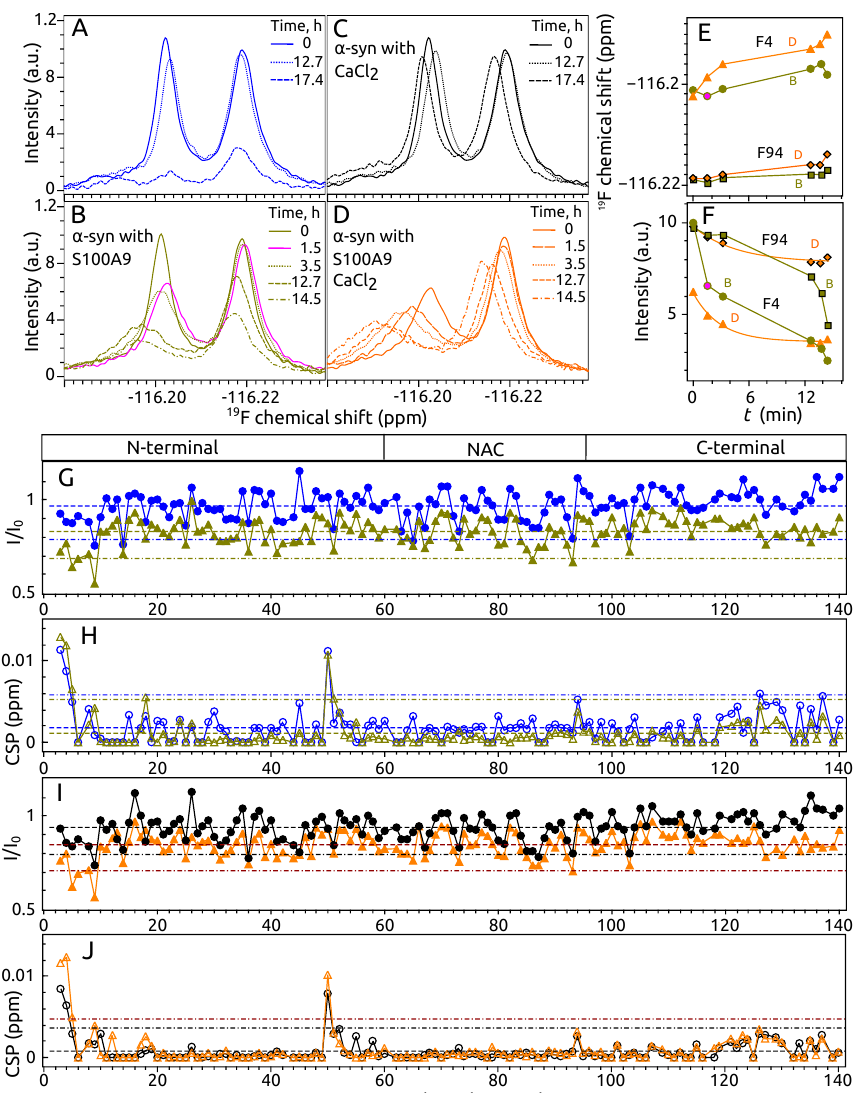
Figure 6. ( A – D ) 19 F NMR spectra of α -syn at different conditions and time points of aggregation: ( A ) α -syn without CaCl 2 , ( B ) α -syn with CaCl 2 , ( C ) α -syn with S100A9 without CaCl 2 , ( D ) α -syn with S100A9 and CaCl 2 . ( E ) Chemical shift and ( F ) intensity of α -syn F4 (dark yellow circles or one pink circle—sample from panel C , orange triangles— D ) and F94 (dark yellow squares—sample from panel C, orange diamonds—D) peaks at different time points during aggregation. ( G , I ) Intensity and ( H , J ) chemical shift change of 15 N α -syn peaks in 15 N– 1 H HSQC spectra after incubation at 37°C, 250RPM for 14 h. ( G , H ) 15 N α -syn solution without CaCl 2 , ( I , J ) 15 N α -syn—with CaCl 2 . Circle points— α -syn, triangles 15 N α -syn in a presence of S100A9. The dashed line is the mean and dash–dot line—two standard deviations (color coded lines and data points). All samples contained 100µM α -syn, 0µM or 100µM S100A9, 0µM or 1mM CaCl 2 , 25mM HEPES, 100mM NaCl, 1mM DTT, 5% D 2 O, 0.02% NaN 3 , pH 7.4. ( A , C ) Intensity and ( B , D ) chemical shift change of 15 N α -syn after incubation at 37 ◦ C, 250 RPM for 14